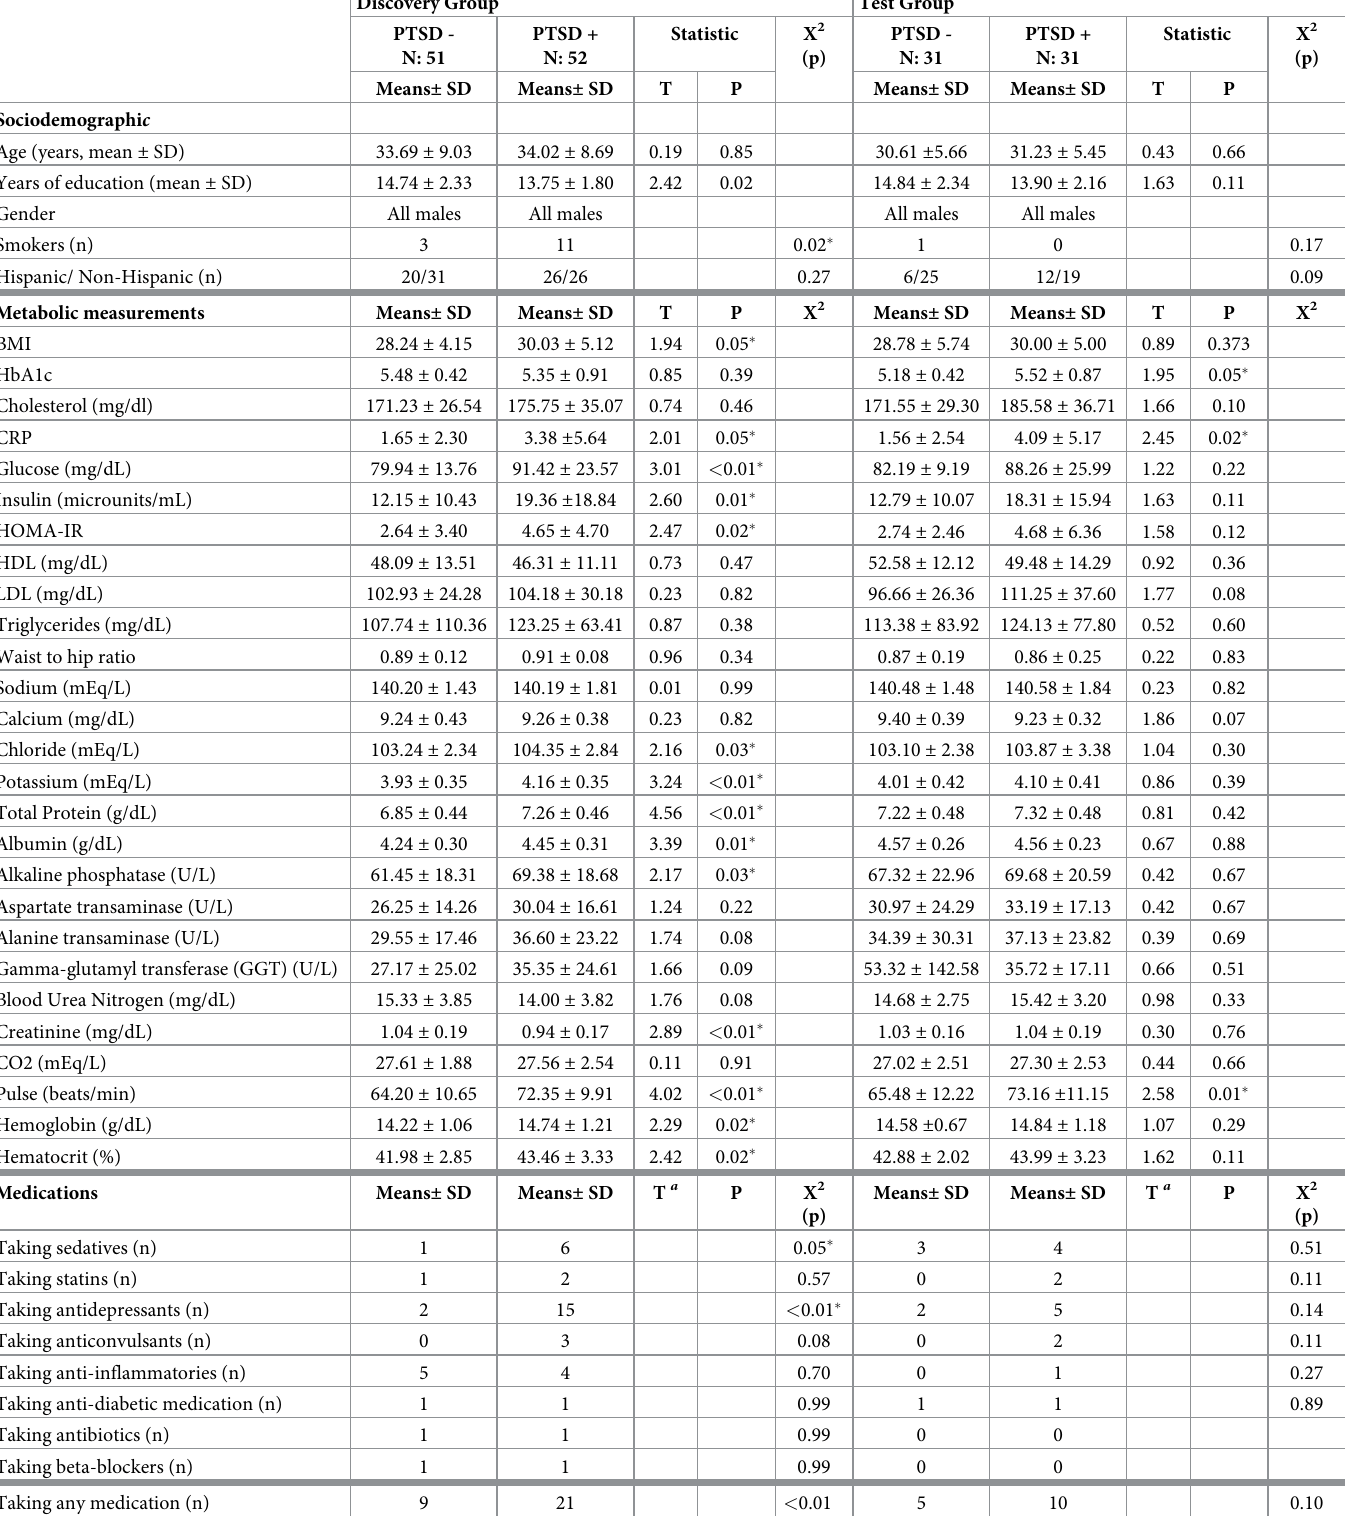
Table 1. Demographic and clinical characteristics of combat veterans with PTSD and controls in Discovery and Test